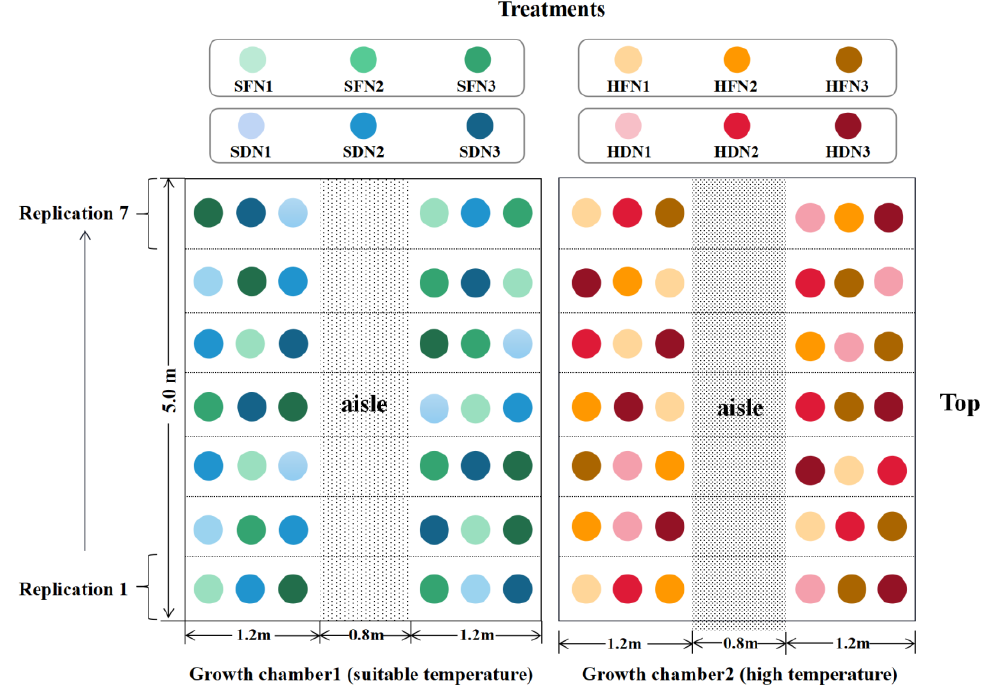
Figure 1. Schematic diagram of the overall experimental layout.